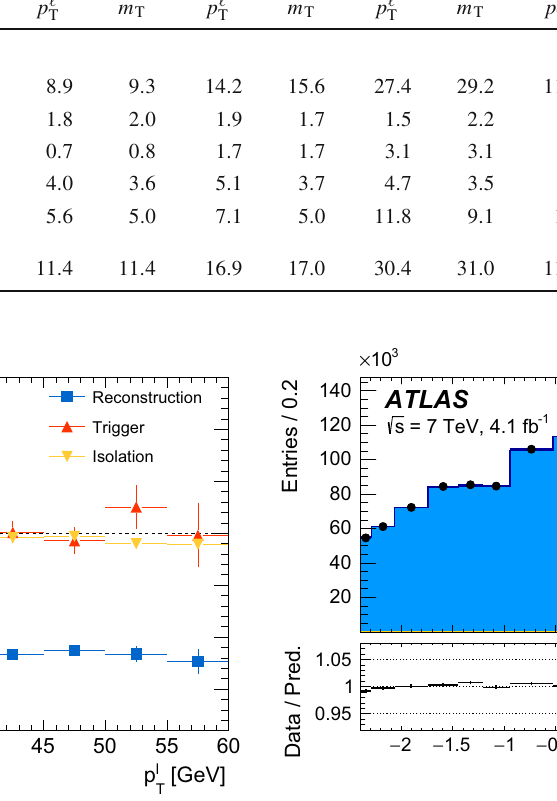
Fig. 7 a Scale factors for the muon reconstruction, trigger and isola- tion efficiency obtained with the tag and probe method as a function of the muon p T . Scale factors for the trigger efficiency are averaged over two data-taking periods as explained in the text. The error bars on the points show statistical uncertainties only. b Distribution of the recon- structed muons η in Z → μμ events. The data are compared to the